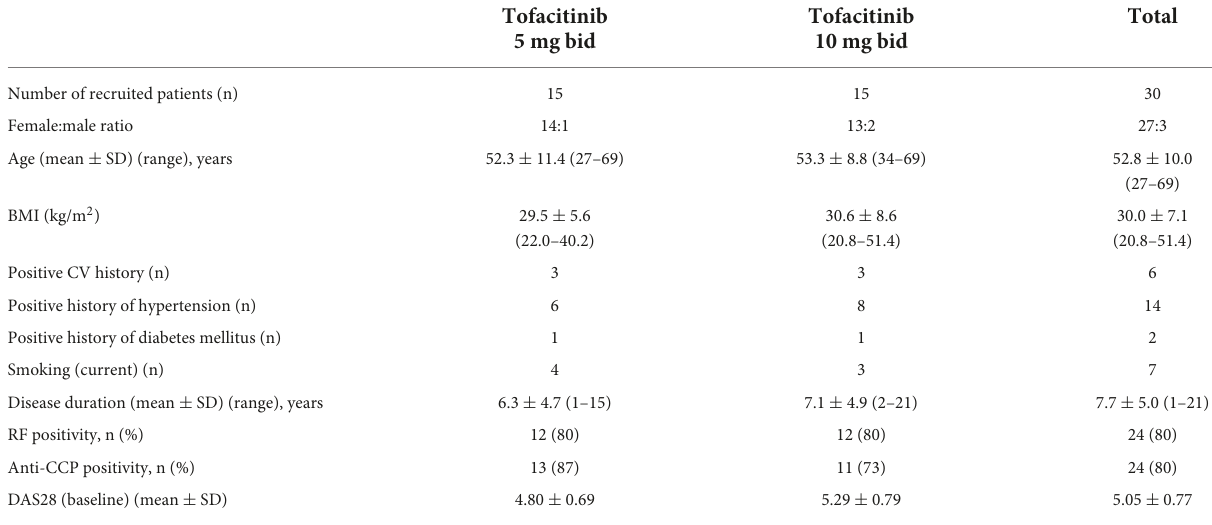
TABLE 1 Patient characteristics.